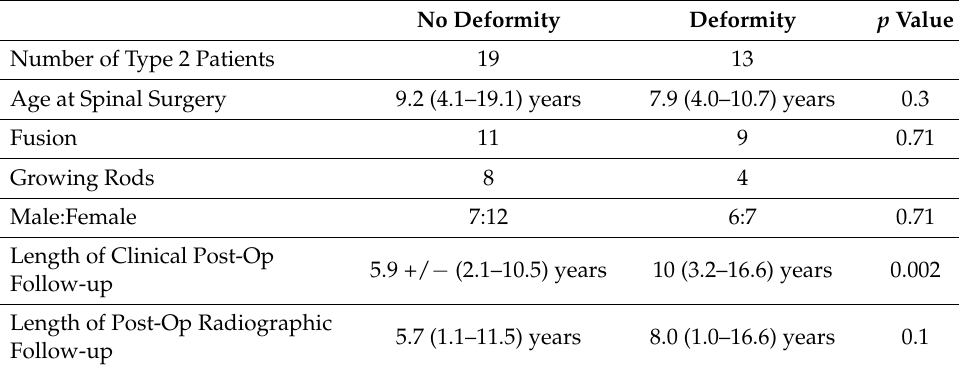
Table 3. Demographic differences between those found with and without obvious deformities on